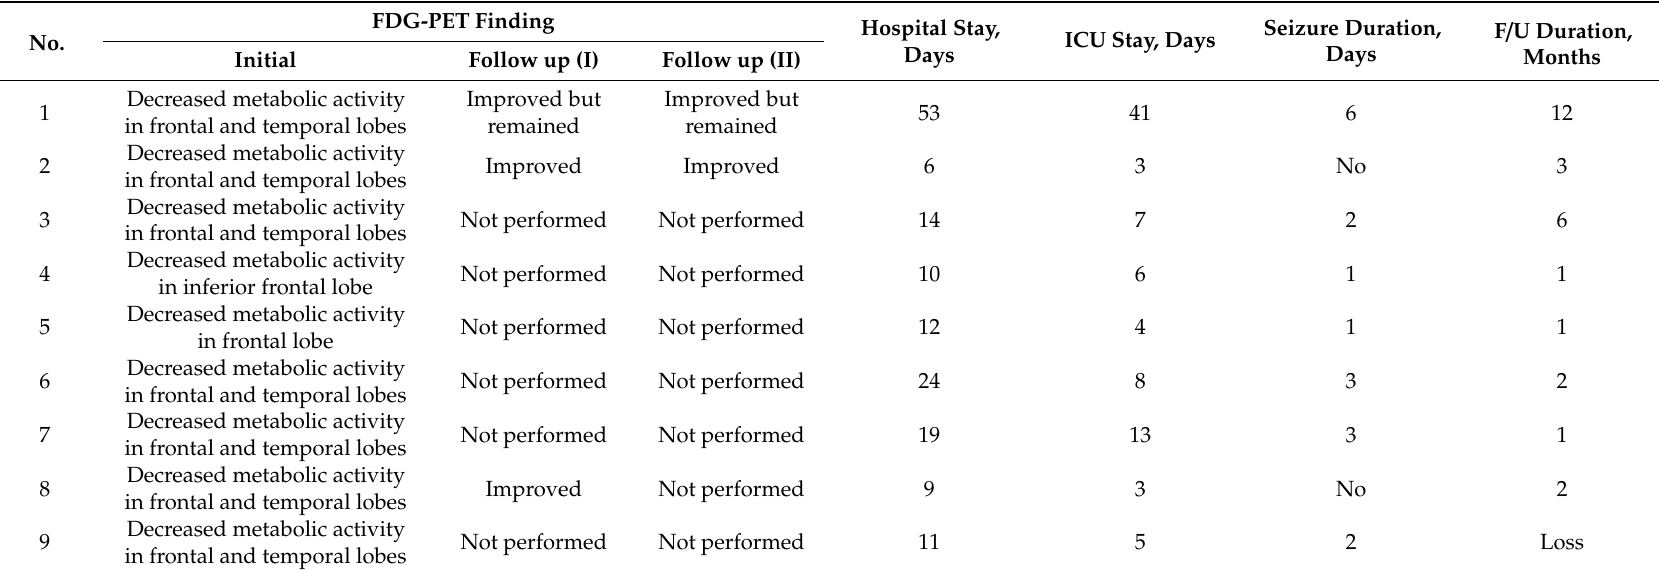
Table 2. The results of the F-18 fluorodeoxyglucose positron emission tomography (FDG-PET) for each patients and clinical information, including hospital days, ICU stay days, seizure duration, and follow-up